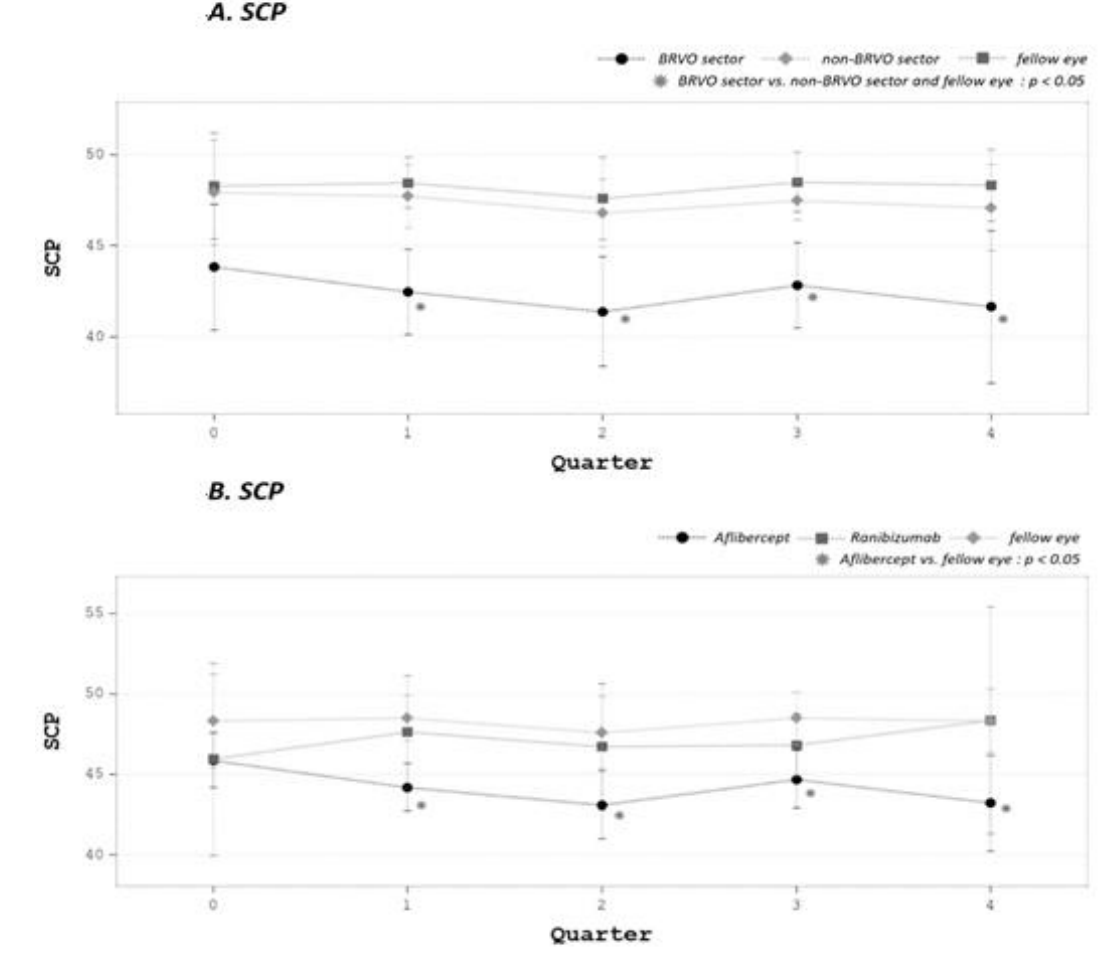
Figure 4. ( A ) SCP in BRVO sectors remained low after the initiation of treatment and reached significance compared with non-BRVO sectors and fellow eye ( p < 0.05). ( B ) In subgroup analysis, the significance was mostly in the aflibercept group. Table 2. NPA, FAZ, SCP, DCP changes in Diseased Eye and Fellow